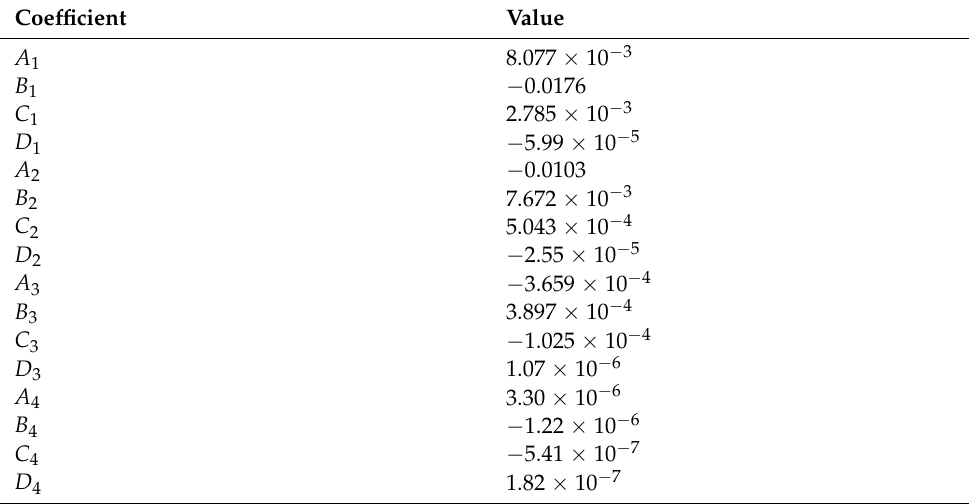
Table 1. Tuned coefficients for Equations (7)–(10).